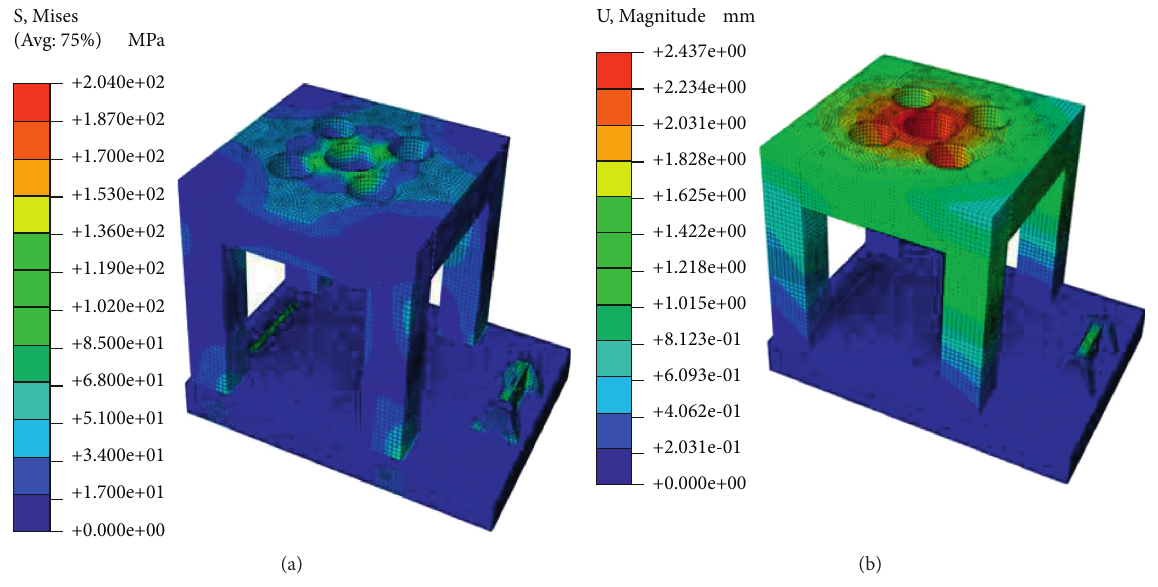
Figure 4: Stress and displacement cloud diagram of the compression-shear test machine frame under the ultimate working condition before optimization. (a) Stress cloud diagram. (b) Displacement cloud diagram.